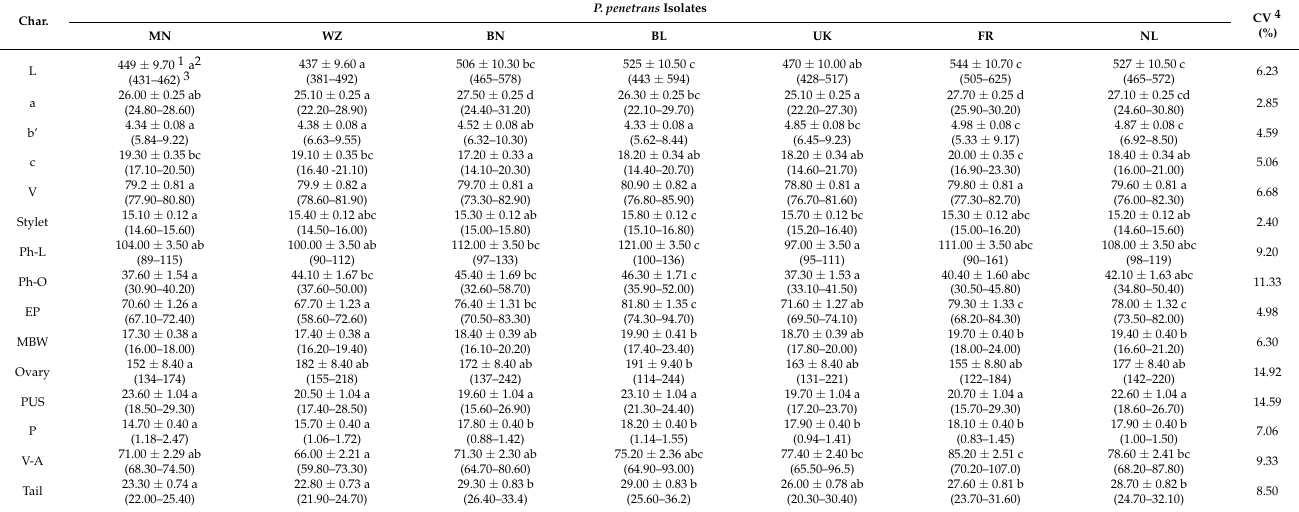
Table 1. Morphometry of the seven European Pratylenchus penetrans female isolates and their geographical origins.